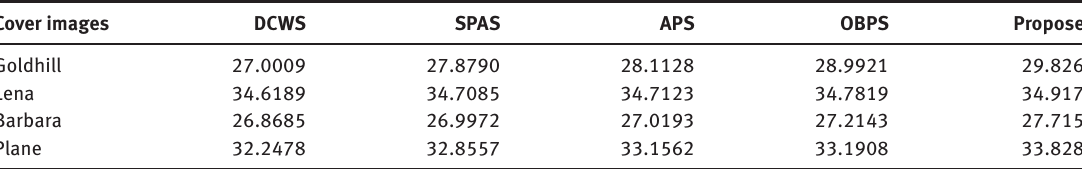
Table 2: PSNR Values of ST Using Baboon as a Secret Image. Cover